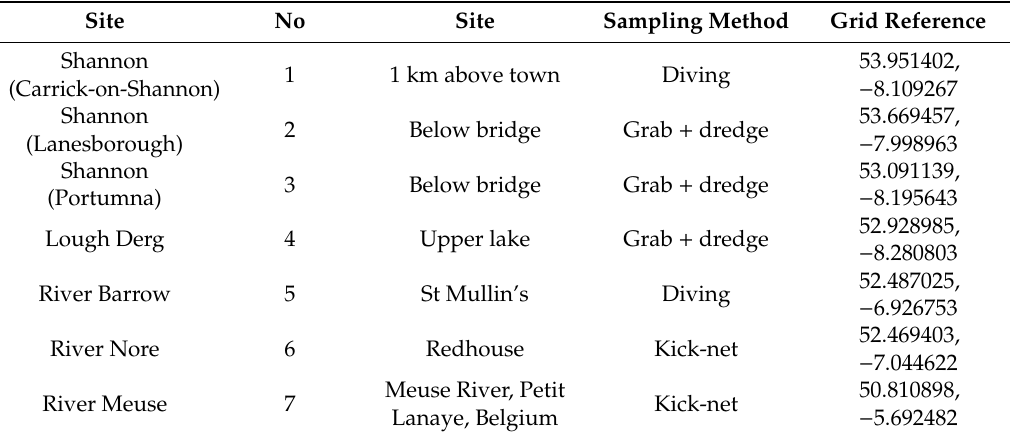
Table 1. Sampling sites and collection methods of Corbicula clams for DNA and morphometric analysis.